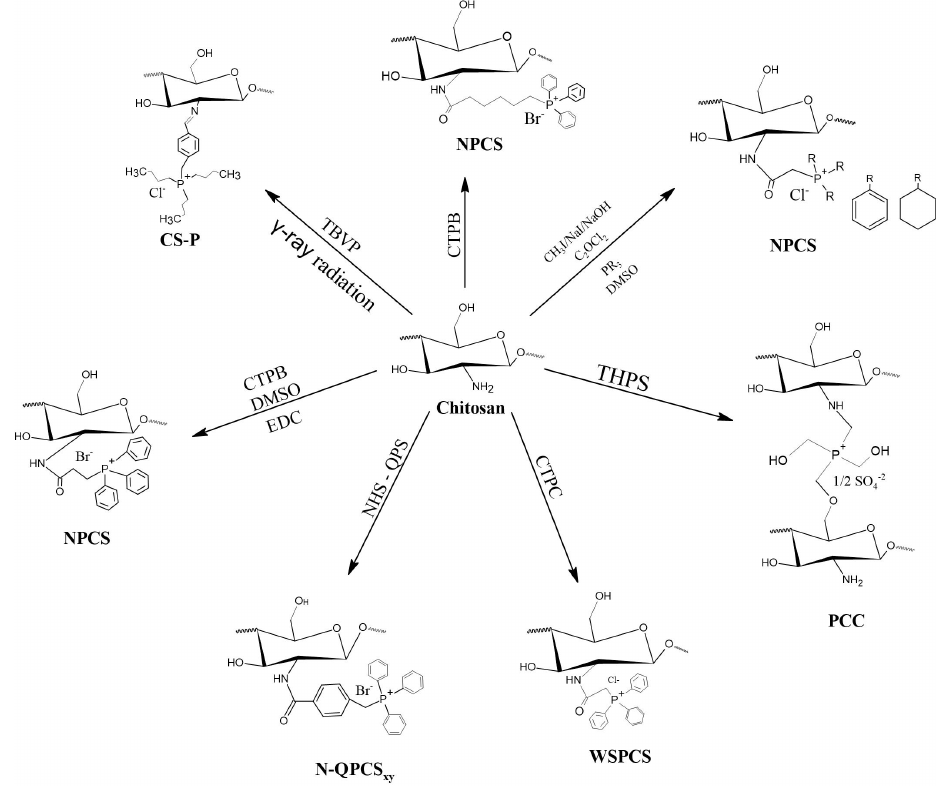
Figure 8. Synthetic route to obtain different quaternized chitosan derivatives with phosphonium